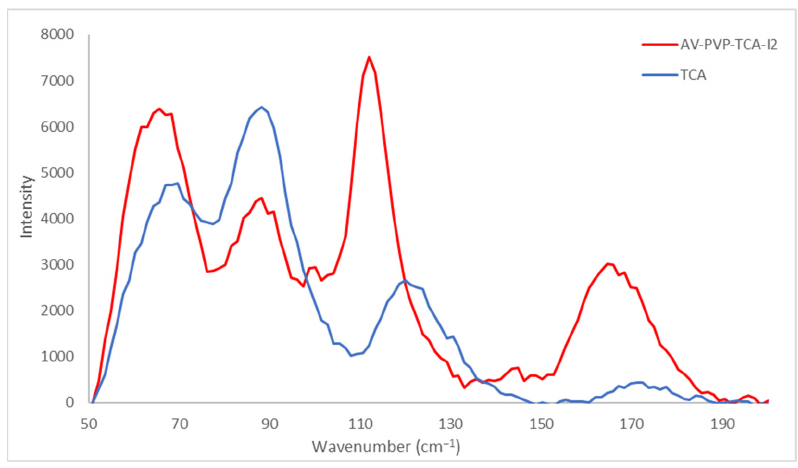
Figure 5. Raman spectroscopic analysis of AV-PVP-TCA-I 2 and TCA. The Raman spectrum of the title compound AV-PVP-TCA-I 2 shows two broad, high- intensity absorptions around 50–130 and intermediate shifts at 150–175 cm − 1 . A broad me- dium-sized absorption band is available from 200 to 455 cm − 1 (Figure 5). Small-sized ab- sorptions are available between 130 and 150 cm − 1 (Figure 5). Such bands originate from a mixture of iodine moieties. The Raman spectrum is clearly dominated by the polyiodide absorption bands (Figure 5, Supplementary File S3). These consist of iodide ions and mo- lecular I 2 within unsymmetrical polyiodide ions, as well as triiodide ions and, probably, pentaiodide ions (Figure 5, Table 1). Table 1. Raman shifts in AV-PVP-TCA-I 2 (1) (cm − 1 ).